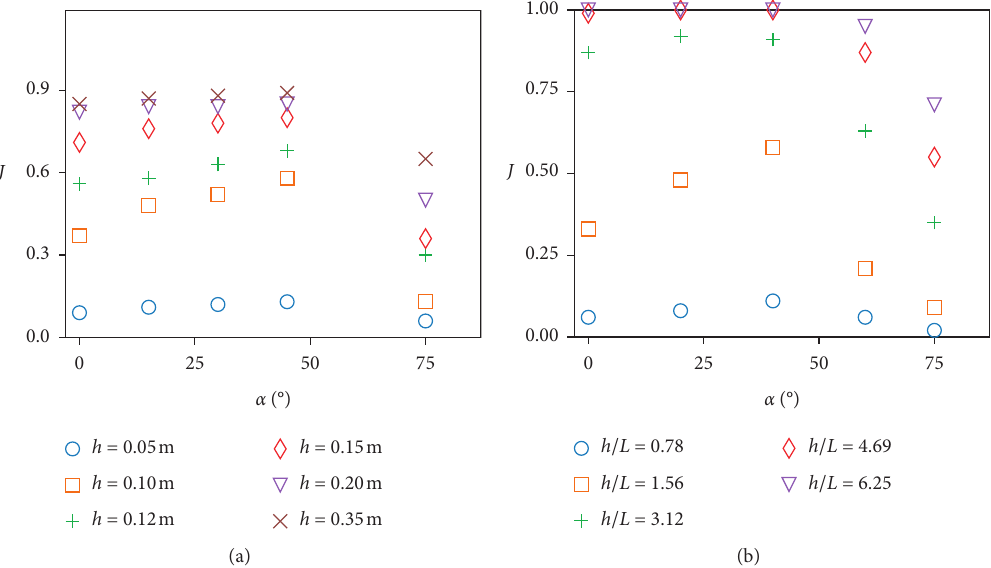
Figure 10: Results of clogging probability J versus hopper angle α for various pebble bed heights h obtained by (a) experiment and (b)